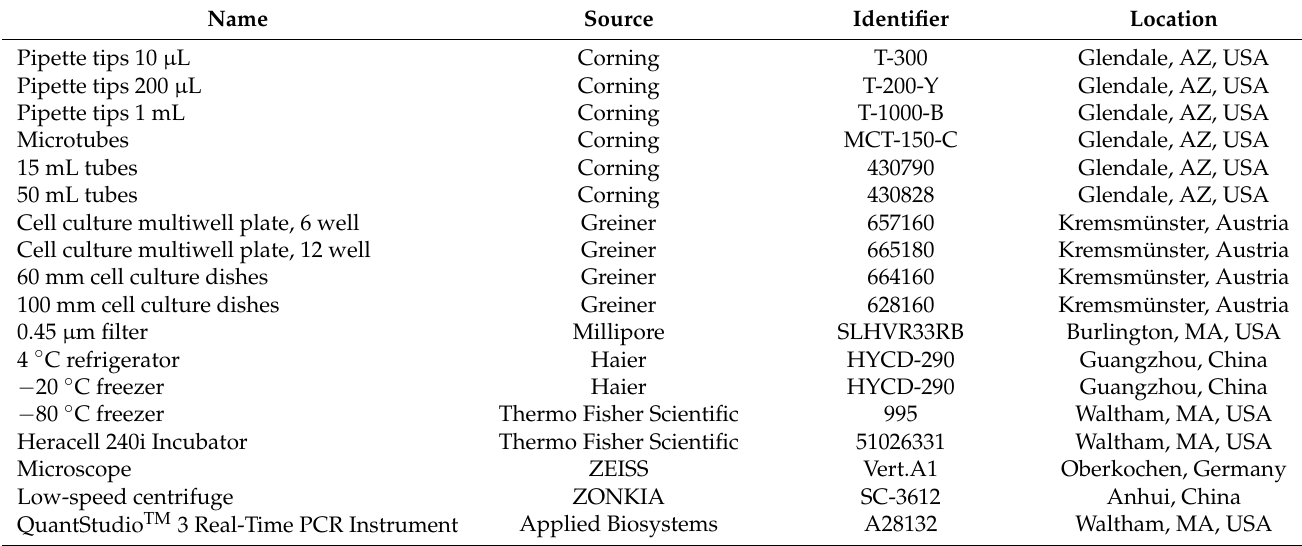
Table 1. Information on all consumables and equipment.